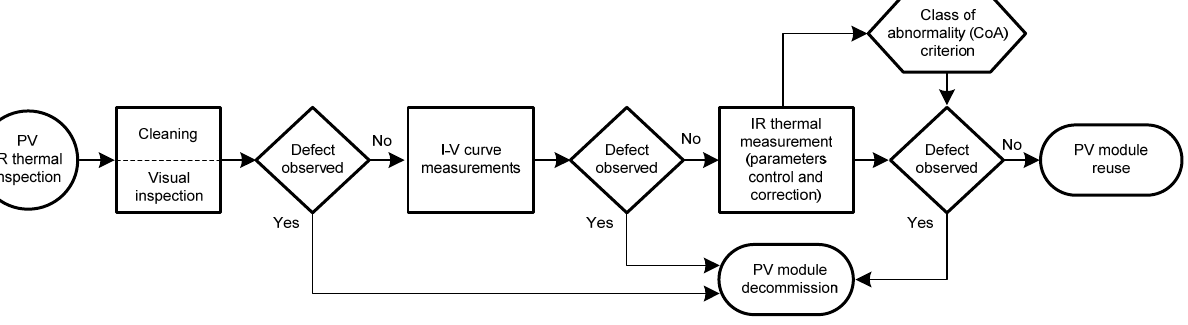
Figure 1. Flow chart of the test procedures.